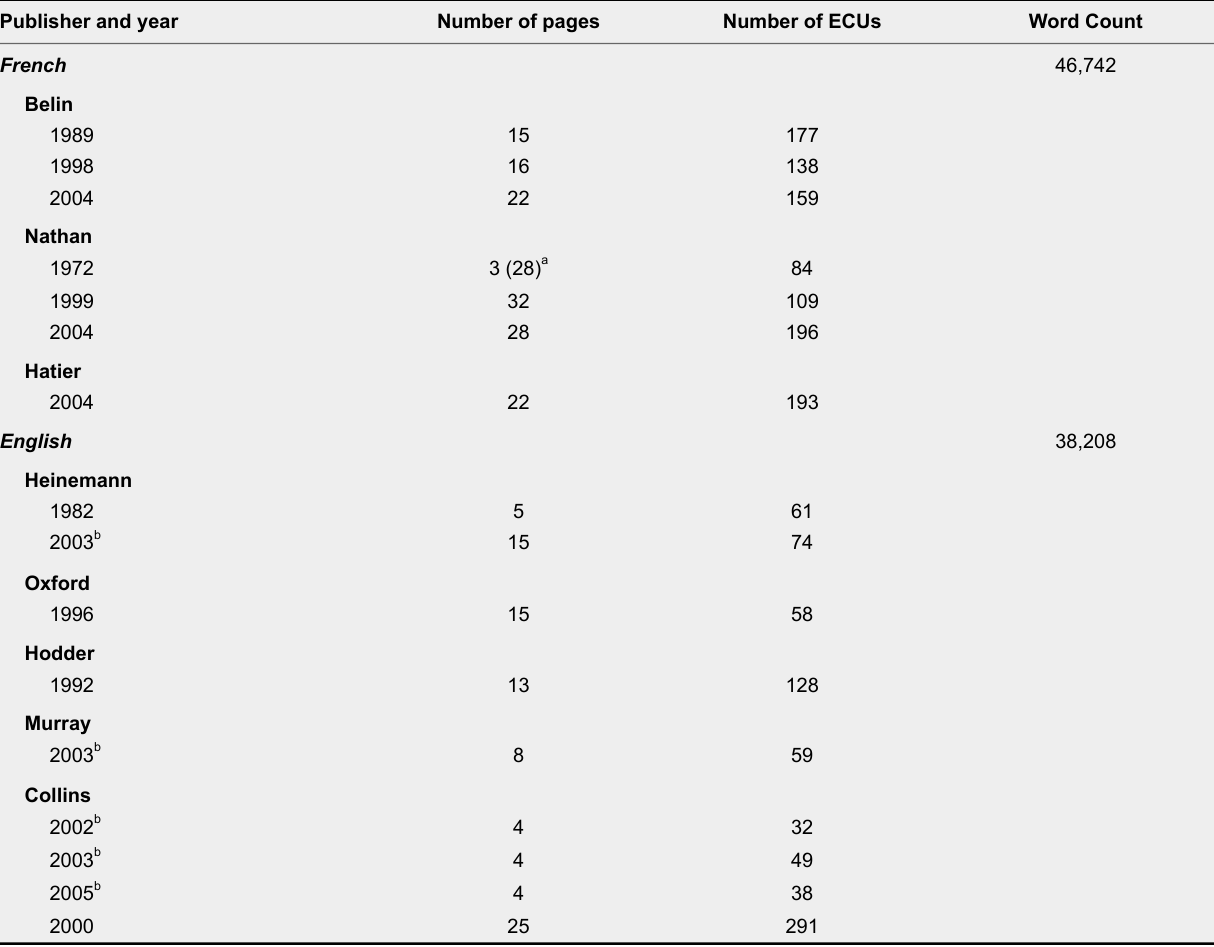
Number of Analyzed Pages and Elementary Context Units (ECUs) in French and English Textbooks.